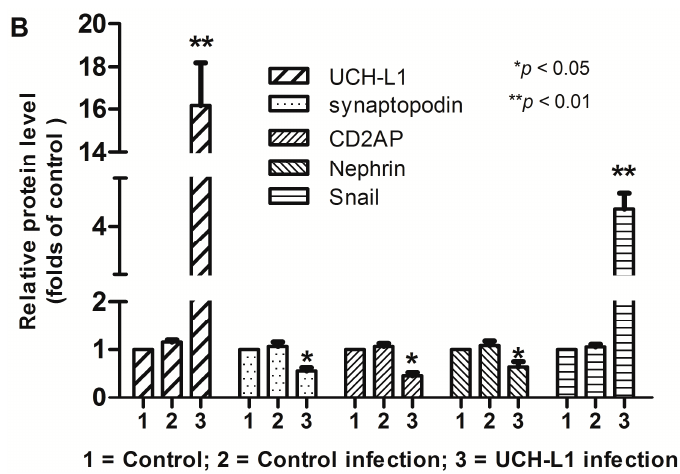
Figure 7. UCH-L1 overexpression induced changes of expression of several proteins in podocytes. Differentiated podocytes were infected with UCH-L1 overexpression adenoviral vector for 48 h. Control cells were treated with vehicle vector or were not treated for 48 h. Podocytes lysate proteins (60 μ g) were analyzed respectively by western blot using murine corresponding antibodies and β -Actin was used as control for protein loading. ( A ) Western blot assay of UCH-L1, synaptopodin, CD2AP, nephrin and Snail; ( B ) corresponding statistic histogram of UCH-L1, synaptopodin, CD2AP, nephrin, and Snail protein expression. Data representative of three independent experiments. * p < 0.05, ** p < 0.01 both versus control group and control infection group.